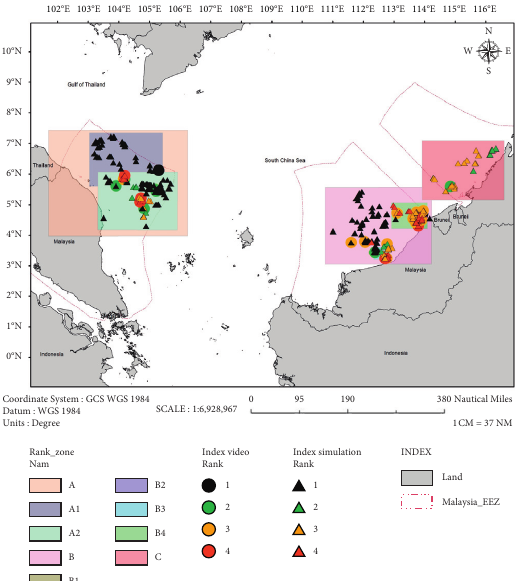
Figure 11: Reef viability ranking for the South China Sea